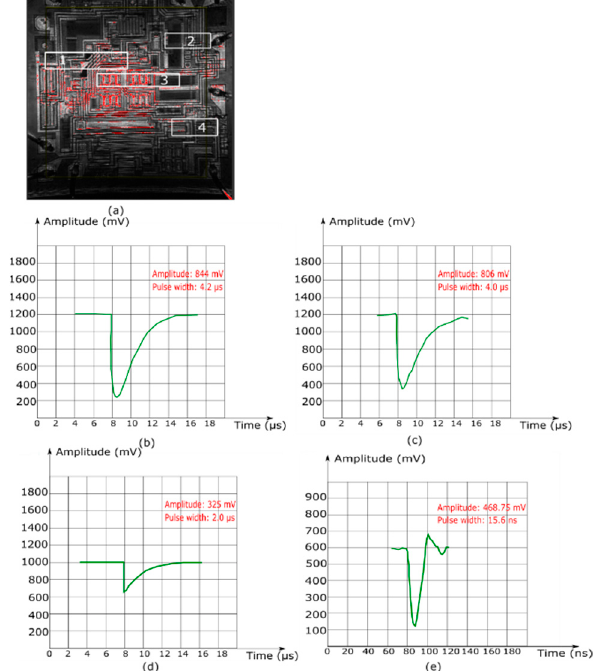
Figure 17. SET results in each ROI. ( a ) distribution of ROIs; ( b ) SET pulse in ROI_1; ( c ) SET pulse in ROI_2; ( d ) SET pulse in ROI_3; ( e ) SET pulse in ROI_4.